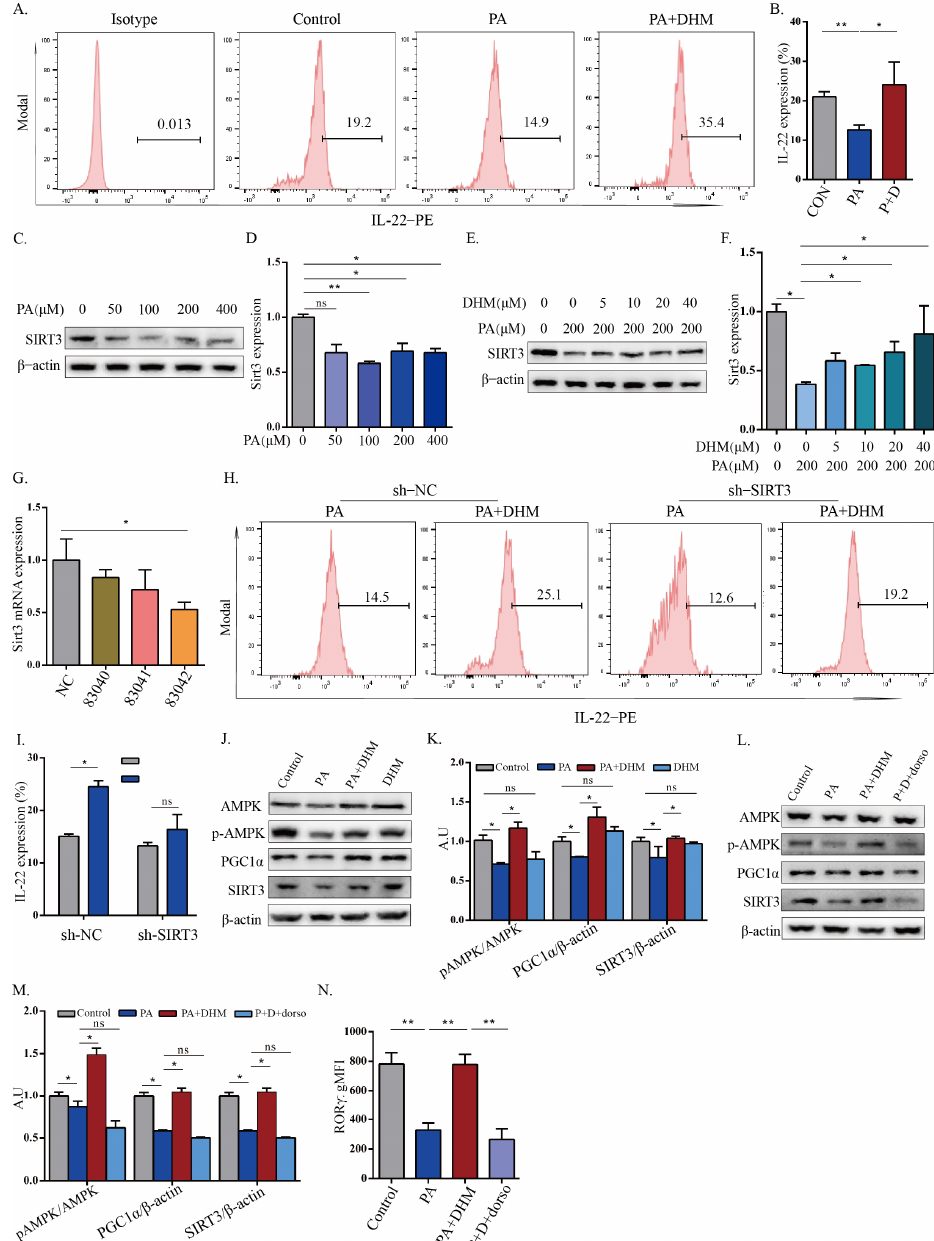
Figure 3. DHM promoted IL-22 expression in MNK3 cells through SIRT3 via AMPK/PGC1 α signaling. ( A , B ) IL-22 expression in the indicated groups was detected by flow cytometry. ( C , D ) The protein expression levels of SIRT3 in MNK3 cells after treatment with different concentrations of PA were detected with Western blotting. ( E , F ) The protein expression levels of SIRT3 in MNK3 cells treated with PA in the presence or absence of DHM were detected via Western blotting. ( G ) The mRNA expression of SIRT3 in MNK3 cells with SIRT3 lentivirus infection. ( H , I ) IL-22 expression in the indicated groups was detected using flow cytometry. ( J , K ) Representative immunoblots of AMPK, p-AMPK, PGC1 α , and SIRT3 in the indicated groups, and quantitative graphs show the ratios of p-AMPK/AMPK, PGC1 α / β -actin, and SIRT3/ β -actin. ( L , M ) Representative immunoblots of AMPK, p-AMPK, PGC1 α , and SIRT3 after pretreatment with AMPK inhibitor, and quantitative graphs show the ratios of p-AMPK/AMPK, PGC1 α / β -actin, and SIRT3/ β -actin. ( N ) The ROR γ t expression levels were detected using flow cytometry. * p < 0.05; ** p < 0.01; ns, non-significance as determined by one-way ANOVA followed by the Tukey–Kramer post hoc